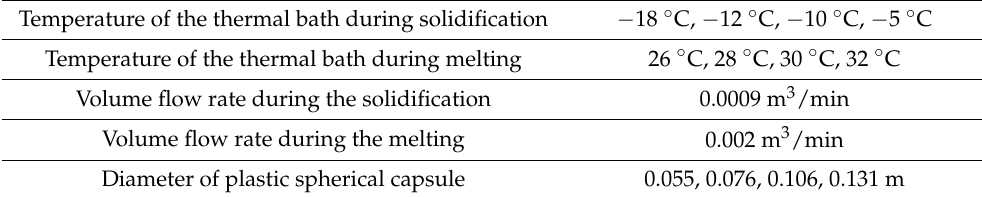
Table 1. Standards of the experimental variables.